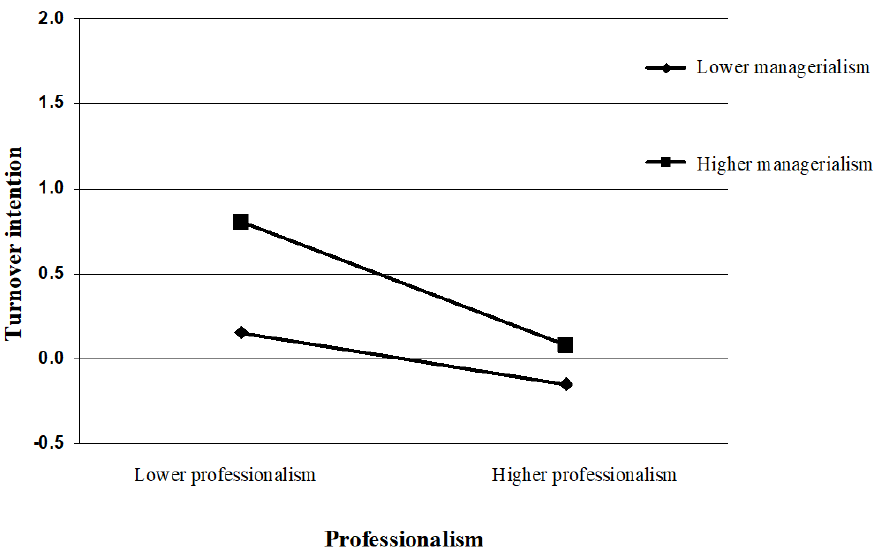
Figure 4. Moderating role of managerialism in the relationship between professionalism and turn- over intention.